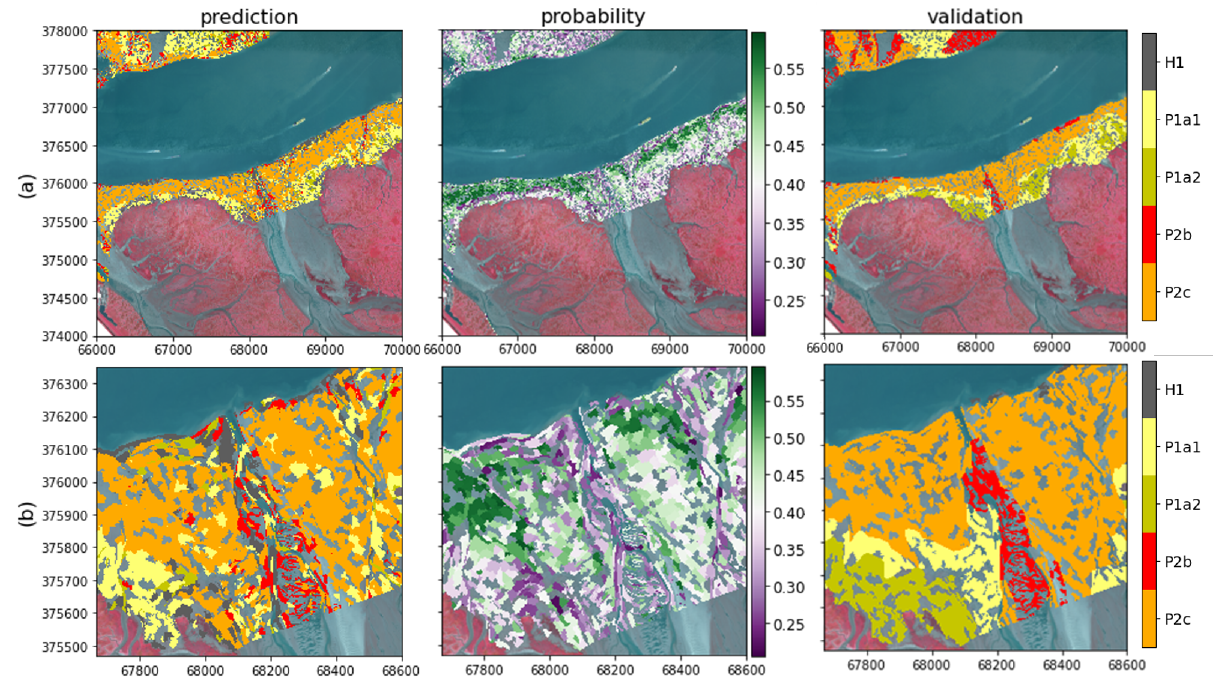
Figure 4. Maps of method OBIA-XGB. Figure (b) is a zoom-in of the figure (a). From left to right: predicted labels, predicted probabilities of the class with highest value, ground truth